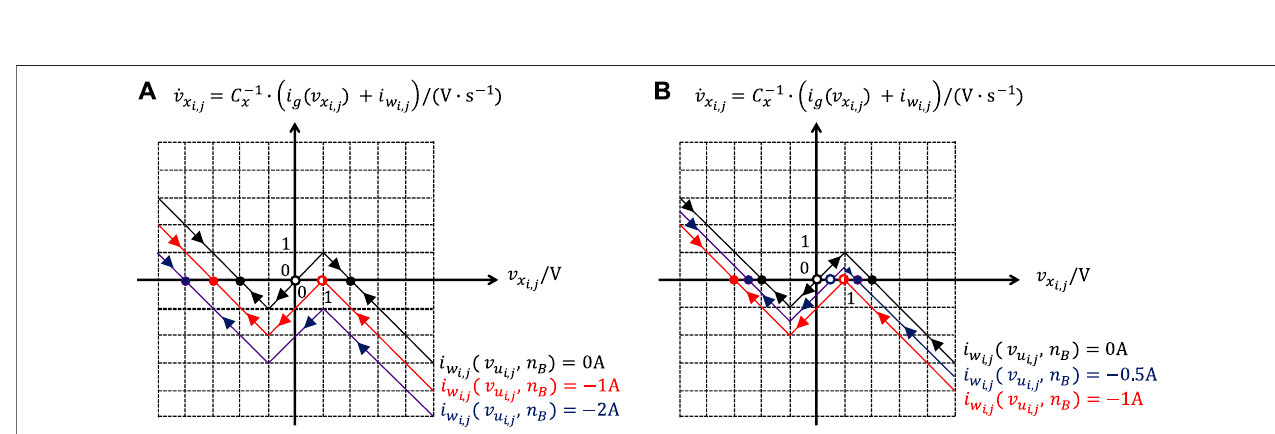
(cid:1) − 2V, at v (cid:1) 0V, and at v (cid:1) x i , j x i , j i , j